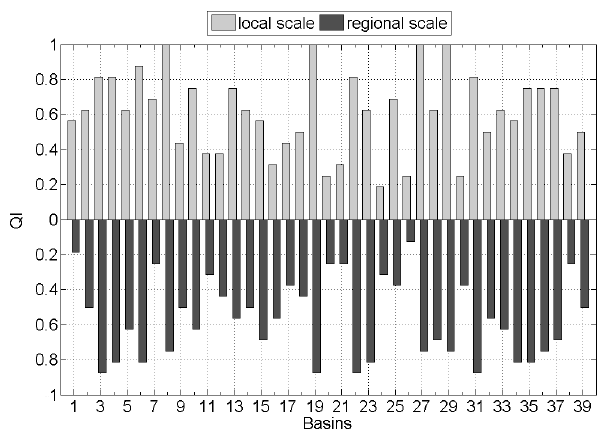
Fig. 7. Summary of the Quality Index QI obtained with the model application at the catchment scale (light gray) and at the regional scale (dark gray). The basin numbers refer to the table in the sup- plementary